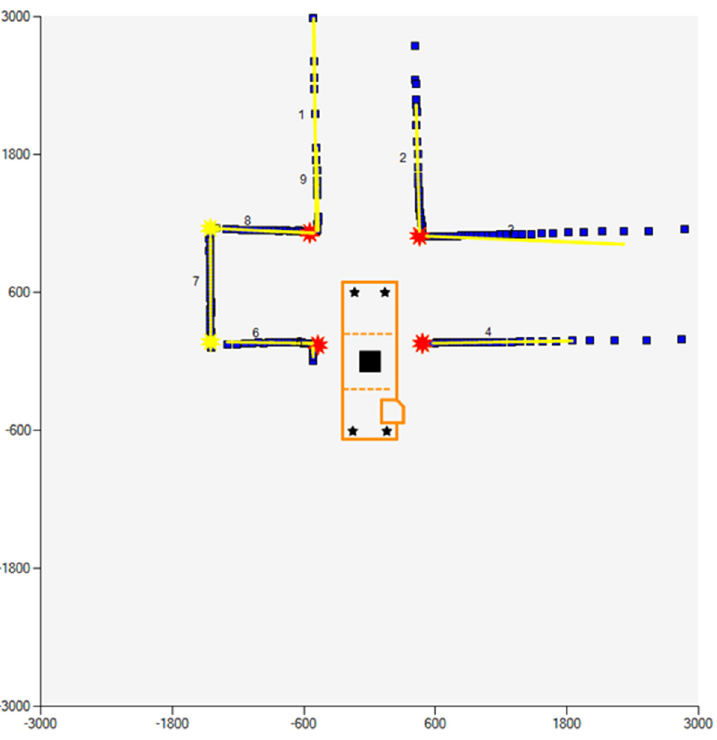
Figure 11. Instance of a created map in the mapping tool. The blue squares denote the collected x–y pairs from the two LiDAR scanners on the direction of movement (in this case, Inby). The yellow linear segments model the ribs of the entries/crosscuts. The red stars denote the four closest detected corners, while the yellow stars denote the remaining detected corners. The black square denotes the center of the shuttle car. The direction of movement is always towards the increasing values of the y -axis.